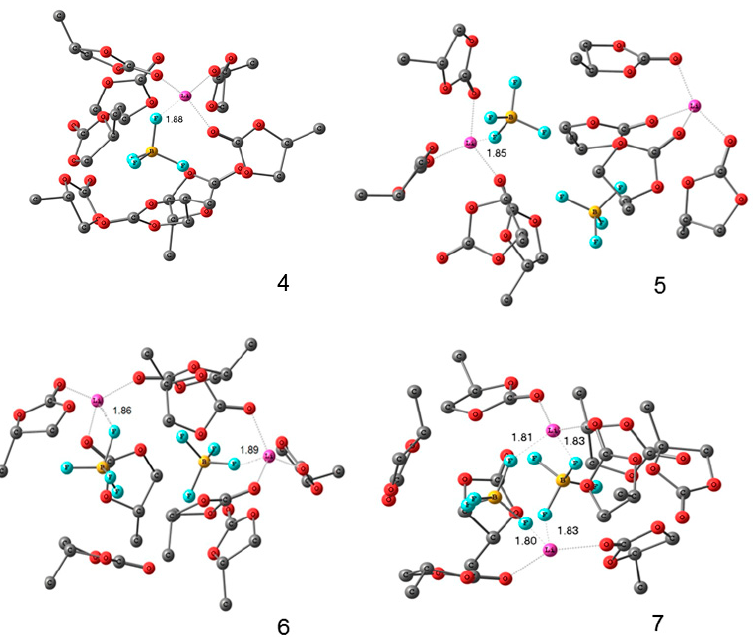
Figure 27. Calculated structures of the solvation complexes without ionic liquid components. Hydro- gen atoms are omitted. Interatomic distances are given in Å [128].